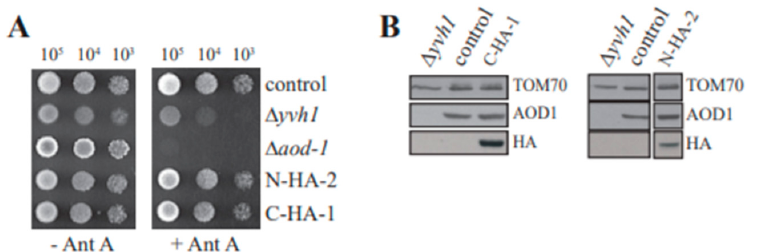
Figure 4. Transformants of Δ yvh-1 expressing the 3xHA-tagged versions of YVH1 have growth rates and AOD1 expression similar to wild type cells. ( A ) Growth of strains N-HA2 and C-HA-1. Serial dilutions of conidia (indicated at top of panel) from the indicated strains were spotted on plates and incubated at 30 °C for 48 h on standard medium ( − AntA) or 68 h on medium containing AntA (+AntA). The control strain is NCN251. ( B ) Western blot analysis of 3xHA-tagged strains. Cultures were grown in the presence of Cm for 20 hr. Crude mitochondrial and cytosolic fractions were prepared from the indicated strains. Proteins were separated by SDS-PAGE, and blotted to nitrocellulose membranes. The crude cytosolic fractions were probed with HA antibody. The mitochondrial fractions were probed with antibodies to AOD1 and Tom70 (loading control). Irrelevant lanes from the right portion of the panel were removed electronically.